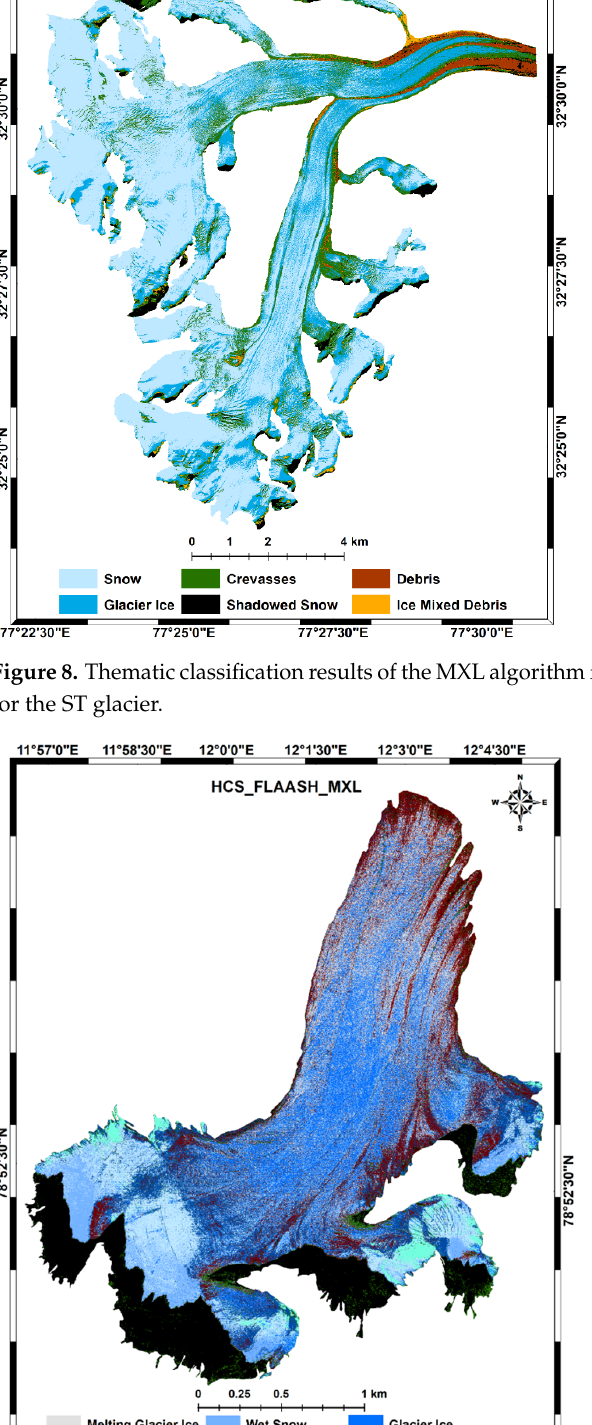
Figure 9. Thematic classification results of the MXL algorithm for the HCS_FLAASH processing scheme for the ML glacier. scheme for the ML